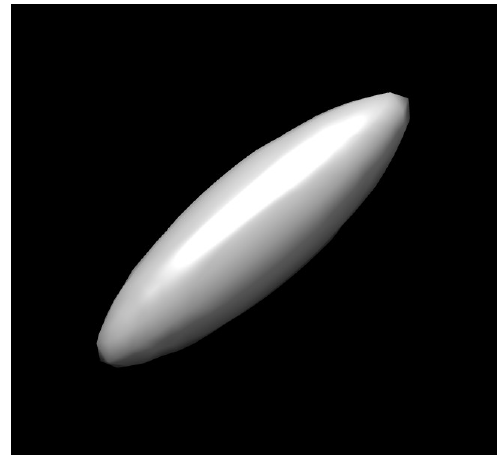
Figure 7. Image reconstructed from one particle per diffraction patten.